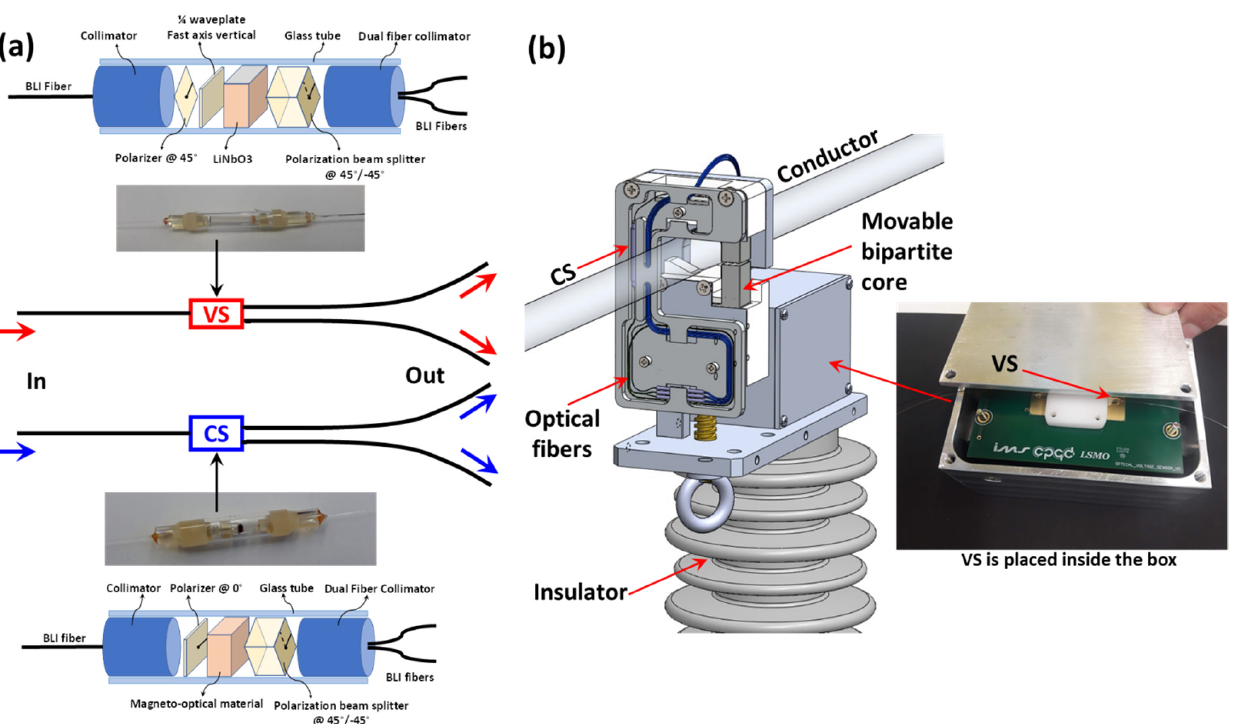
Figure 1. ( a ) Optical setup of the voltage (VS) and current (CS) optical sensors; ( b ) sensor head showing details of the placement of the VS and CS in the packaging.